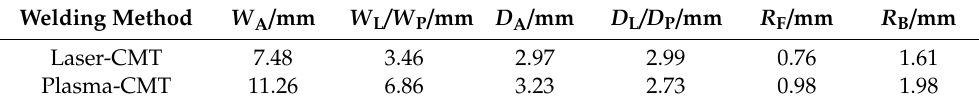
Table 3. The geometric dimensions of each zone of the two hybrid welds.